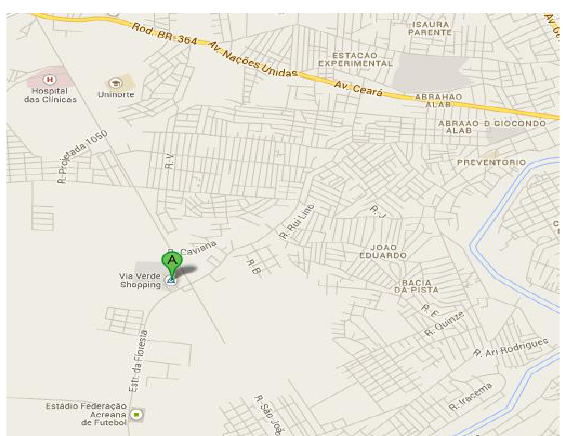
Figure 3b. Location of the transitional environment (store), indicated with the letter A. City map: Rio Branco, Acre, Brazil.